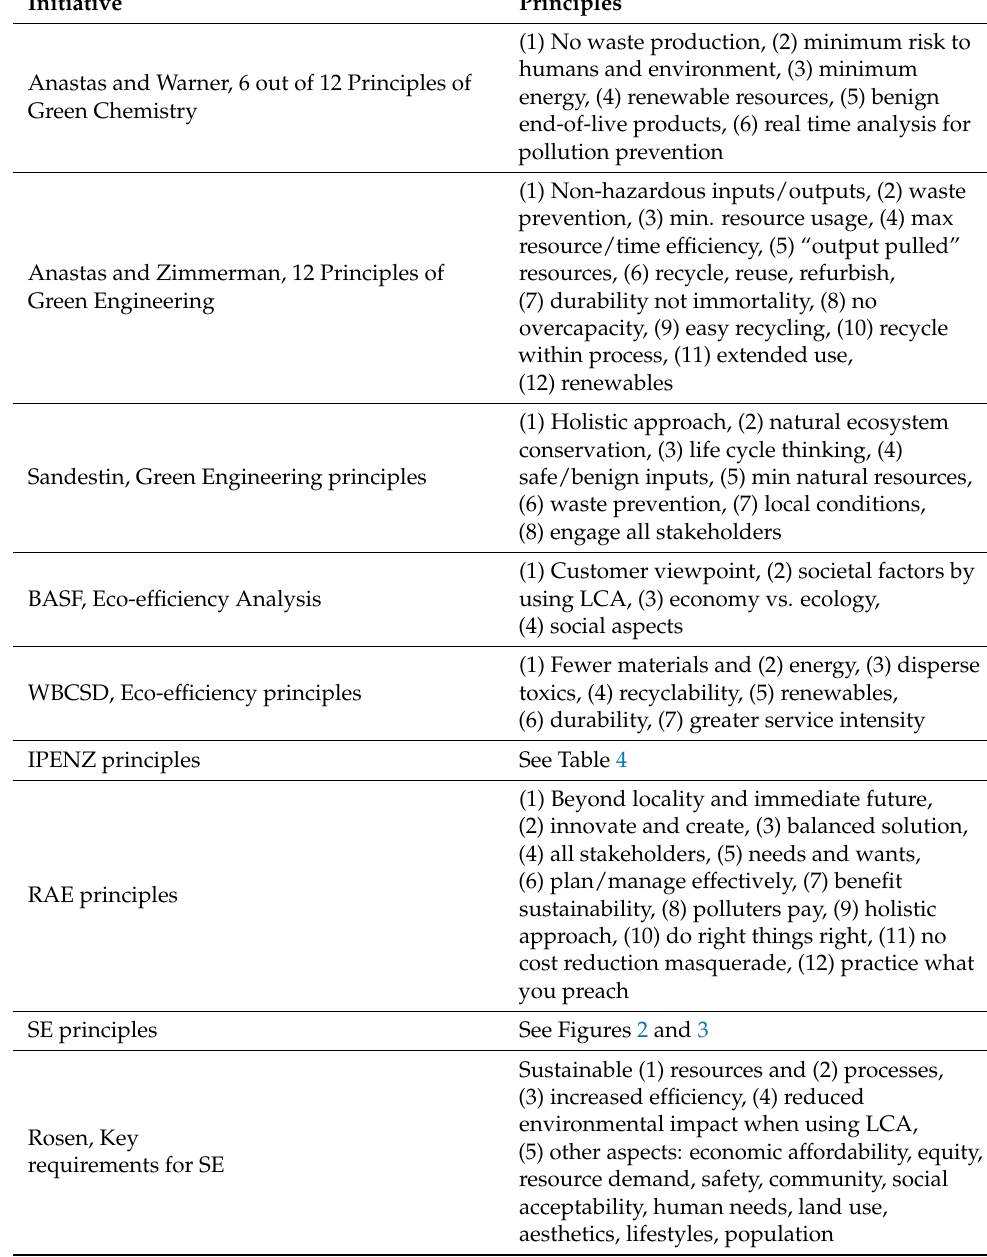
Table 3. An overview of sustainable engineering